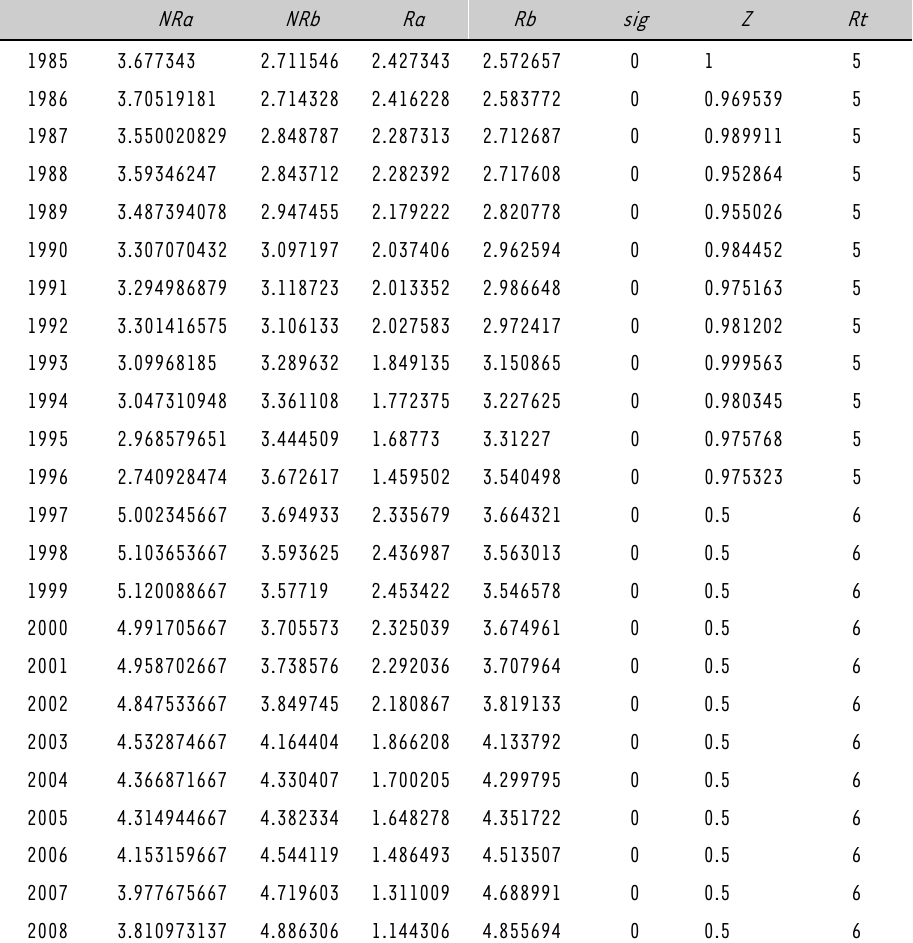
TABLE 7: Data used for South Africa to simulate the reaction function between the ‘environmentalist’ and the ‘energy producer’, when the rainfall increases in 1997 NRa NRb Ra Rb sig Z